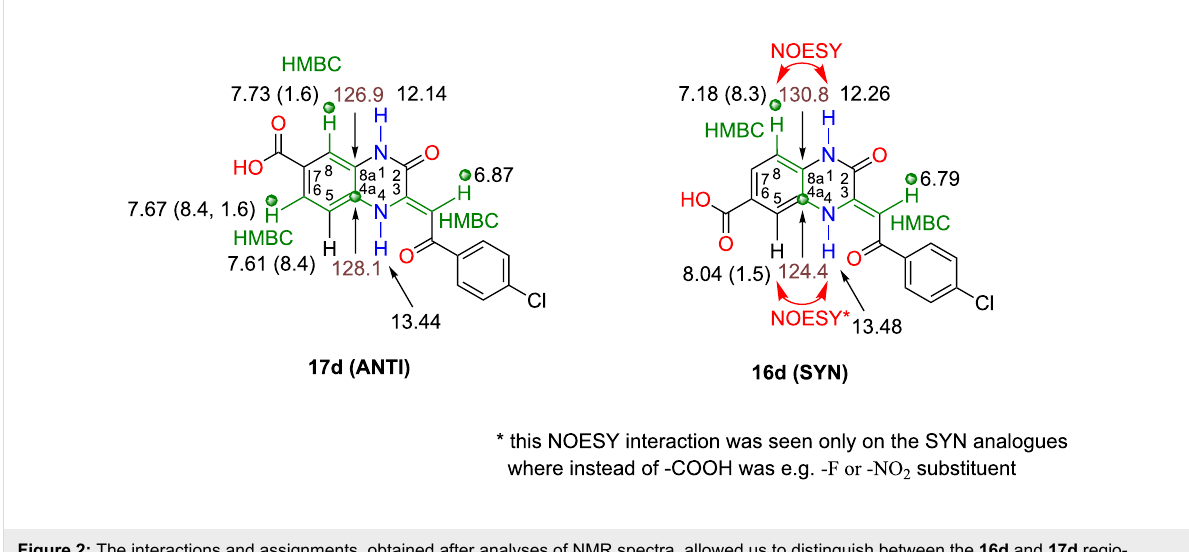
Figure 2: The interactions and assignments, obtained after analyses of NMR spectra, allowed us to distinguish between the 16d and 17d regio- isomers. The important 1 H and 13 C NMR chemical shifts are depicted close to each appropriate atom in the structures accompanied with an coupling constant in brackets, if there was any. The double-headed red arrows represent important space interactions observed in NOESY spectra. The green- coloured bonds in the structures represent some of the most important HMBC interactions that helped us when assigning the right regioisomers. The HMBC signals between the skeletal proton and carbon are limited to 2, 3 and sometimes also to 4